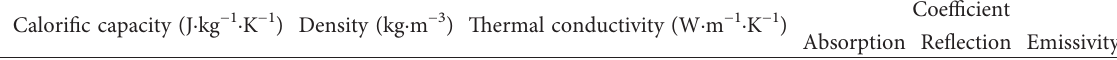
Figure 3: Synoptic of the regulated dryer with solar energy source. Table 1: Thermophysical properties of materials.